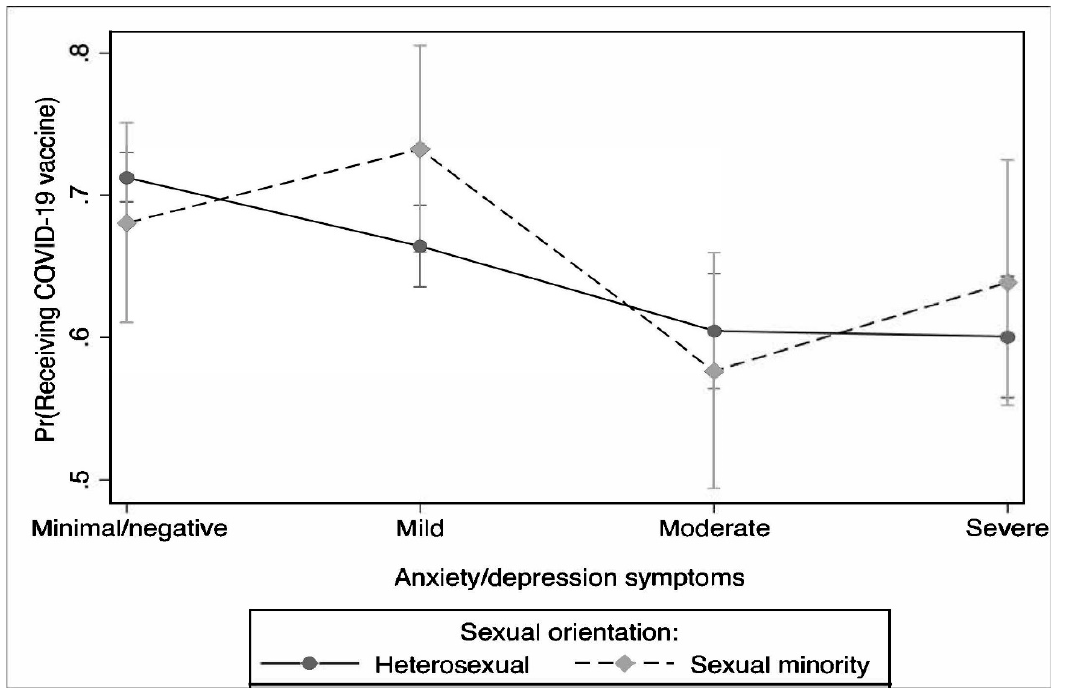
Figure 3. Differences in the perceived likelihood of receiving the COVID-19 vaccine between and within sexual orientation and anxiety/depression symptoms.